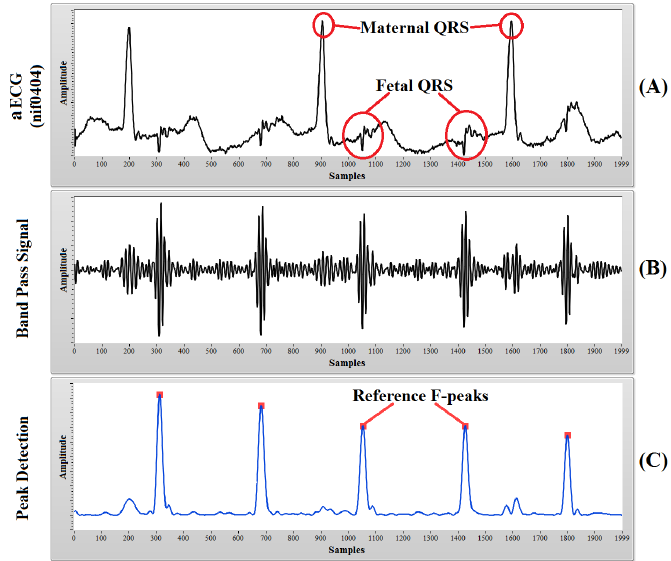
Figure 4. The process of finding the reference fetal R-peaks: ( A ) aECG signal of 2000 samples from record nif0404; ( B ) band passed signal (60–100-Hz band); ( C ) detected fetal R-peaks, which are considered as reference fetal QRS annotations for the “nifecgdb”